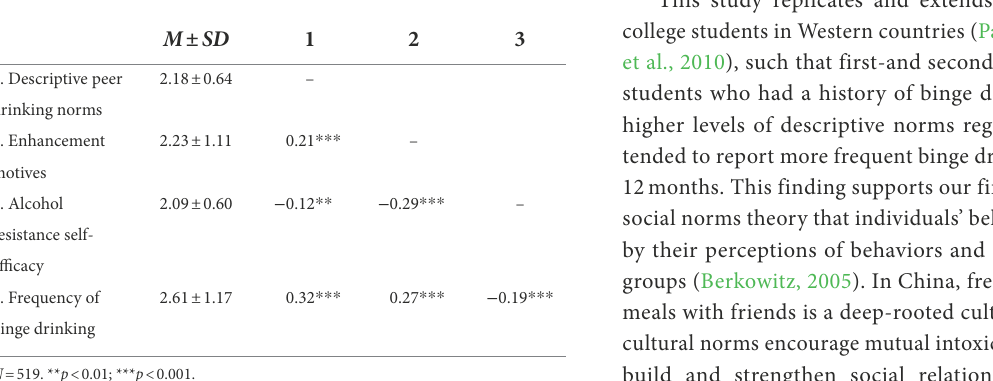
TABLE 1 Means ( M ), standard deviations ( SD ), and correlations among variables.